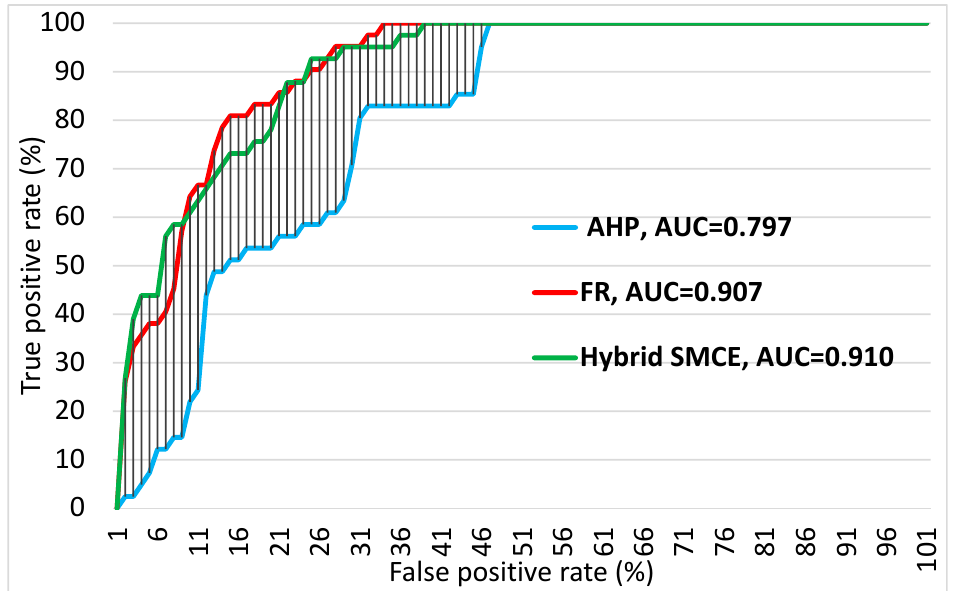
Geosciences 2019 , 9 , x FOR PEER REVIEW Figure 4. Results of ROC plots for the produced susceptibility maps. Figure 4. Results of ROC plots for the produced susceptibility maps.